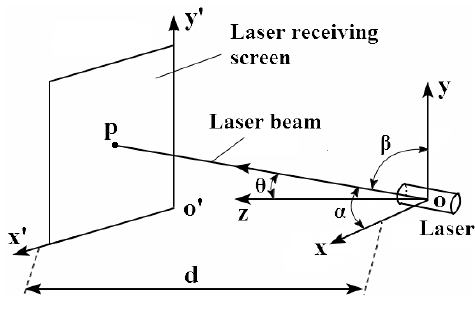
Figure 3. Mathematical model.